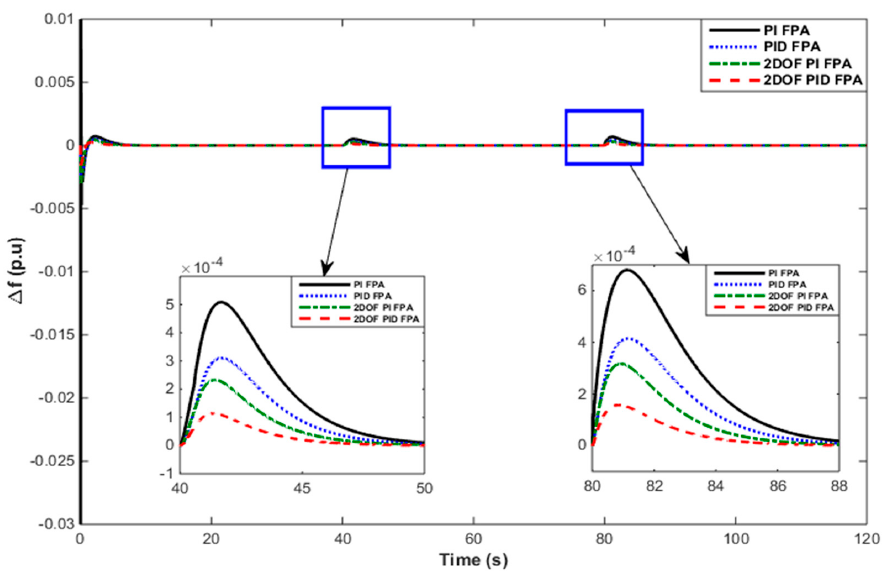
Figure 11. Comparative changes in the frequency deviations observed with the FPA-optimized PI, PID, 2DOF PI, and 2DOF PID controllers in case 3.